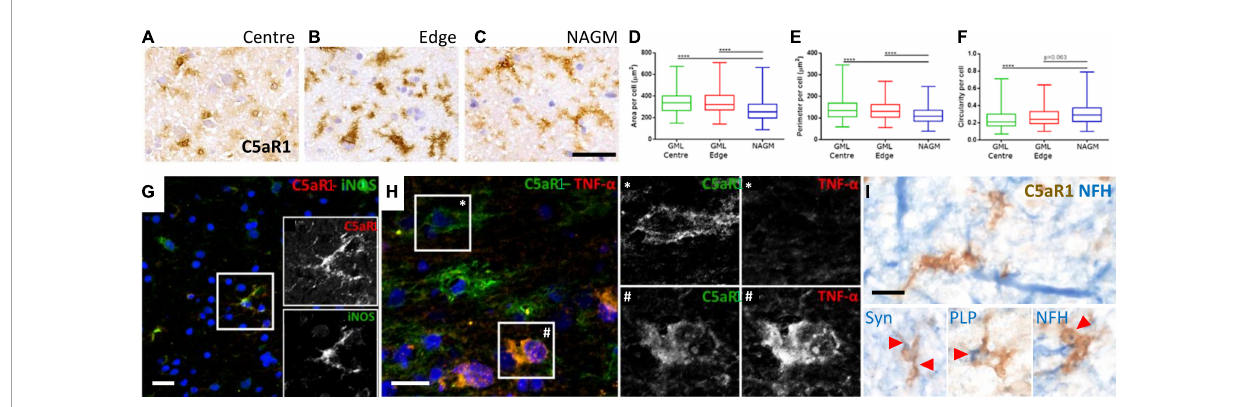
FIGURE6 Activated C5aR1 + microglia/macrophages in cortical grey matter lesions. C5aR1 + microglia/macrophages in the centre or at the edge of subpial lesions display an altered morphology (A–C) and were quantifiably larger in area (D) , with a smaller perimeter (E) , and were more circular (F) , in comparison to C5aR1 + cells of the paired normal appearing GM (NAGM). C5aR1 + microglia/macrophages in a chronic active cortical GM lesion (case MS438) demonstrating dual-immunostaining for iNOS ( G and inset), and TNF α ( H and inset ∗ , #). C5aR1 + microglia-like cells (brown immunostain) in close apposition to neurofilament-H + neurites (blue reaction product; I ) or associated with inclusions of neuronal (synaptophysin, Syn +) and myelin (PLP +) products of degeneration. Scale bars, panels (A–H) = 25 µ m; panel (I) = 10 µ